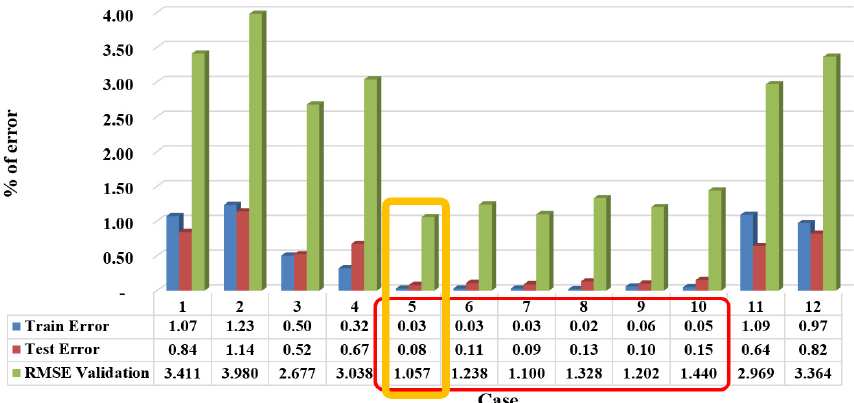
Figure 4. Error results comparison of the Soil Moisture value forecasting in different cases of learning rate (LR) and split ratio (SR)—LSTM model.